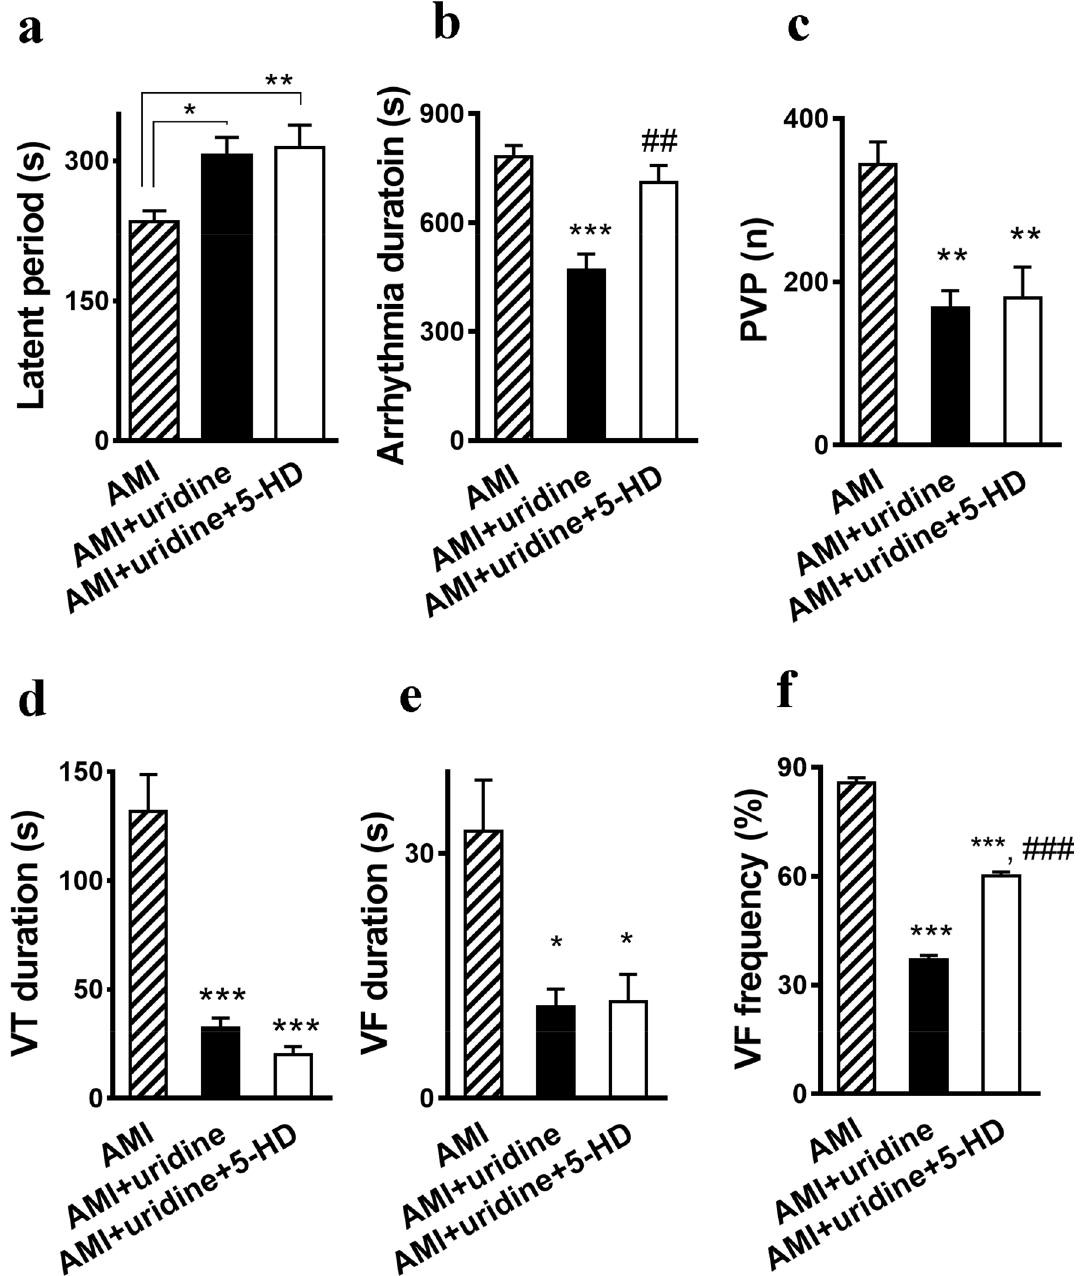
Figure 3. Effect of uridine on early postocclusion arrhythmia. ( a ) A latent period between the LCA occlusion and the first episode of arrhythmia and ( b ) the duration of arrhythmia. AMI ( n = 11), AMI + uridine ( n = 7), AMI + uridine + 5-HD ( n = 7). Effect of uridine on the arrhythmia manifestation: number of PVP ( c ), duration of VT ( d ), duration of VF ( e ), frequency of VF ( f ). Abbreviations: AMI, acute myocardial ischemia; 5-HD, 5-hydroxydecanoate; PVP, premature ventricular beats; VT, ventricular tachycardia; VF, ventricular fibrillation. All data (except F) are the mean ± SEM. * p < 0.05 versus AMI group, ** p < 0.01 versus AMI group, *** p < 0.001 versus AMI group, ## p < 0.01 versus AMI + uridine group, ### p < 0.001 versus AMI + uridine